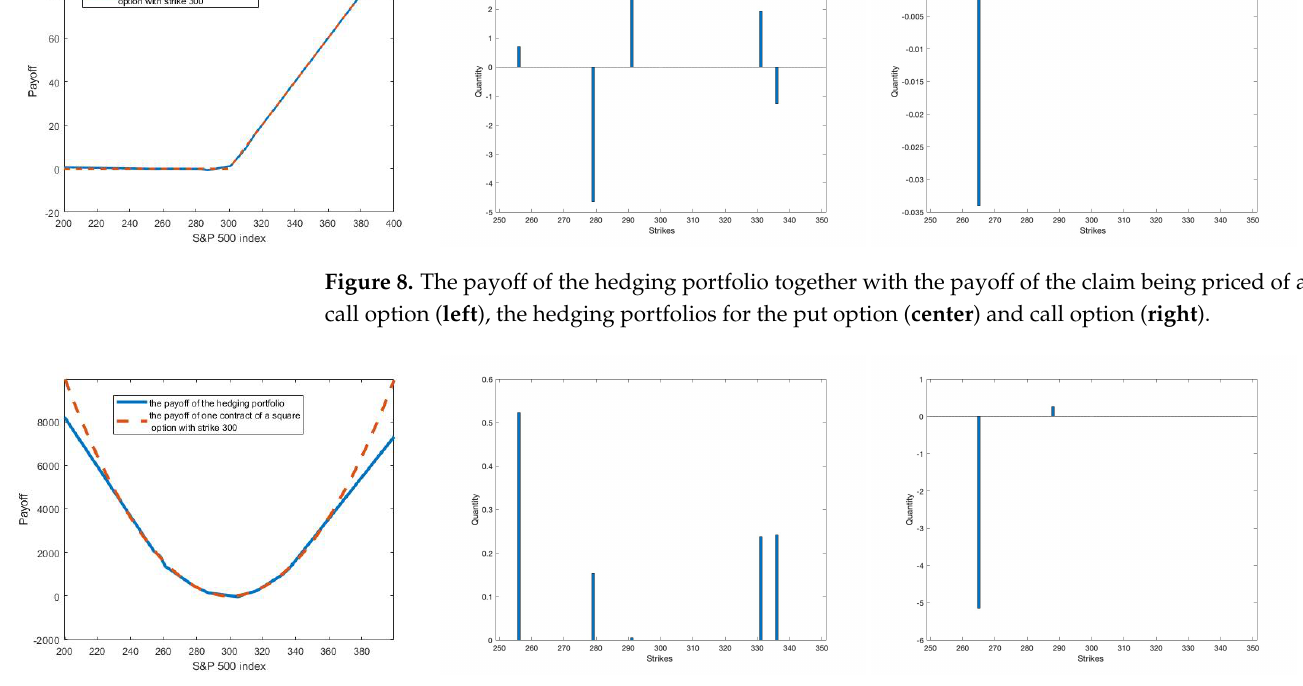
Figure 9. The payoff of the hedging portfolio together with the payoff of the claim being priced of a quadratic option ( left ), the hedging portfolios for the put option ( center ) and call option ( right ).